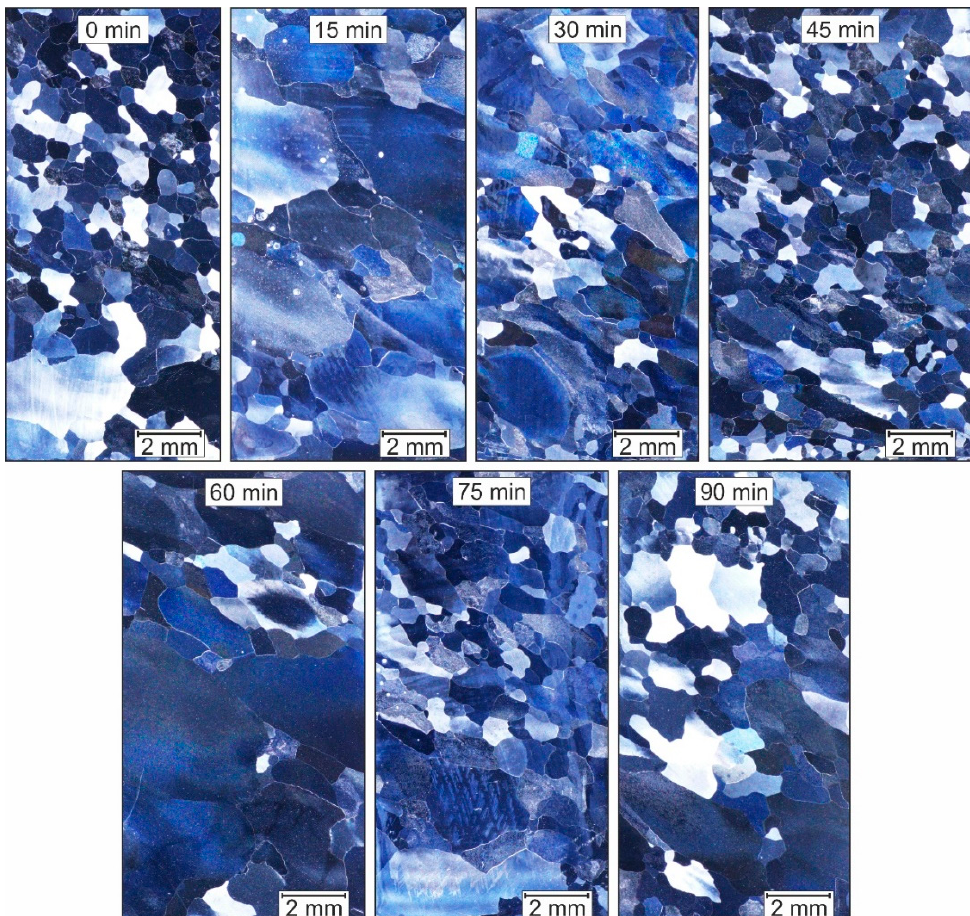
Figure 3. Fe9Al after one ECAP Pass and heat-treated at 750 °C with different holding times. Table 1. Comparison between Fe9Al formed through ECAP plus being heat-treated at 750 °C for different holding times, and the results of cast/bulk-formed Fe9Al at 1100 °C with 2 h of heat treatment (ht) [16]. Holding Time of ht in min.